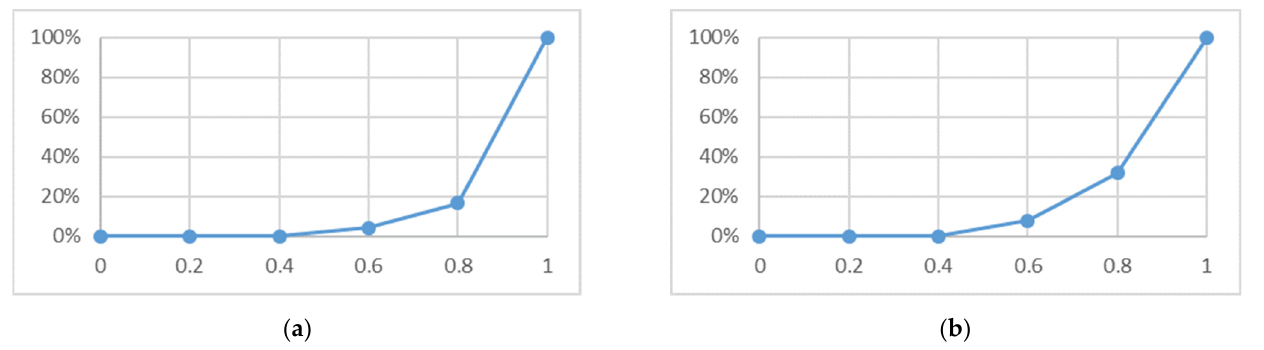
Figure 6. Cumulative percentage diagram of the obtained values of the coefficients of determination R 2 : ( a ) Percentage distribution of the coefficients of determination R 2 for the whole sample of analyzed data, evaluated for the driving direction AB; ( b ) Percentage distribution of the obtained values of the coefficients of determination R 2 for the whole sample of analyzed data, evaluated for the driving direction BA.